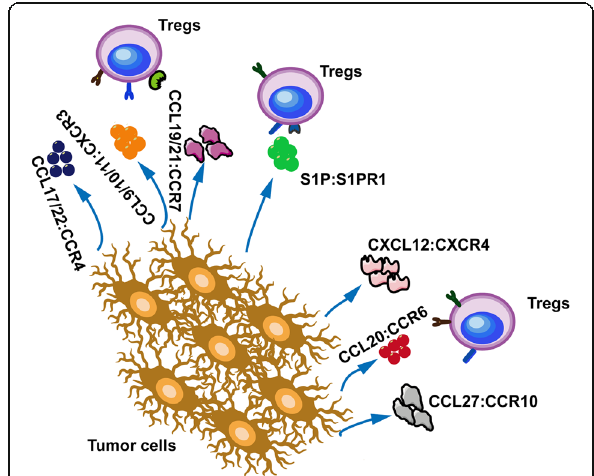
Fig. 1 Recruitment of Tregs to the TME. Tregs are recruited to the TME through specific chemokines and their receptors. A number of chemokines are involved in Treg-trafficking to melanoma, including